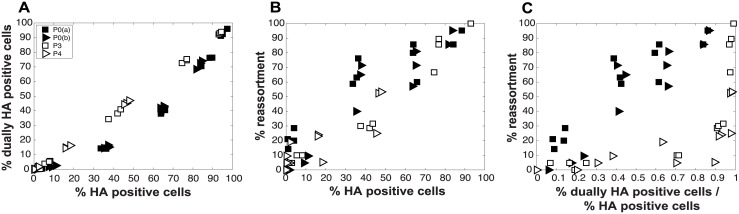
Virus populations dominated by DI particles give rise to a higher proportion of dually HA positive cells but a lower proportion of reassortant progeny viruses compared to virus populations with low DI content.Pan/99wt and Pan/99var viruses with matched passage histories were mixed in equal proportions (P0wt + P0var, P3wt + P3var and P4wt + P4var). Each mixture was used to inoculate MDCK cells at a range of MOIs, in triplicate. MOIs of P3 and P4 virus infections were calculated based on RNA equivalents relative to P0, such that comparable numbers of particles/cell were used in each case. A) Relationship between % HA positive cells and % dually HA positive cells. B) Relationship between % HA positive cells and % reassortment. C) Relationship between the proportion of HA positive cells that are dually HA positive and % reassortment. Results from two independent experiments are shown: data labeled as P0a were obtained in parallel with those for P3 and data labeled as P0b were obtained in parallel with those for P4.